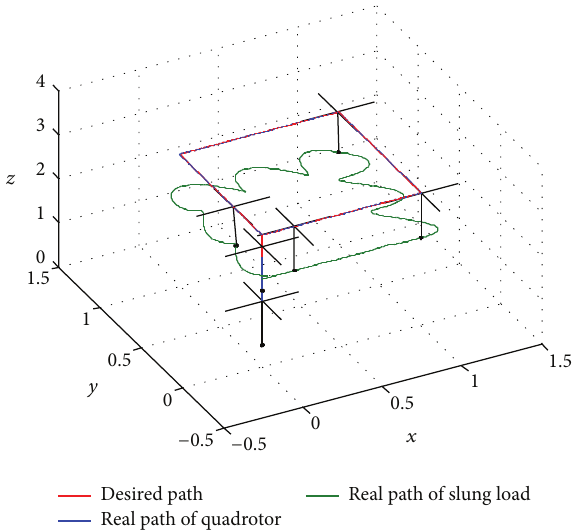
Figure 19: Square path of quadrotor without input shaping con- troller.